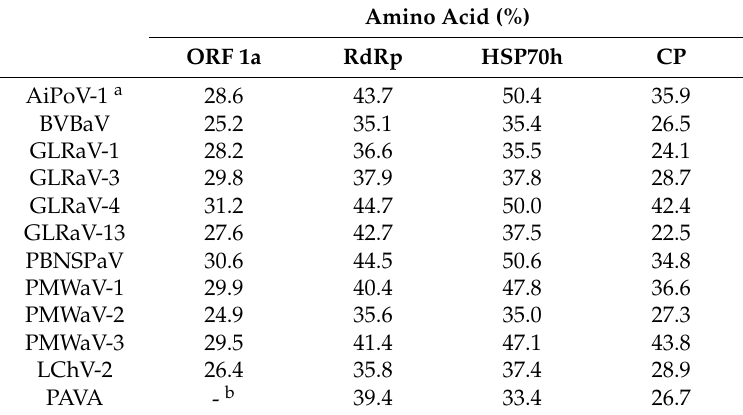
Figure 2. Multiple alignments of FLRaV open reading frames (ORFs) with other ampeloviruses. ( a ) Multiple alignments of ORF1a L-PRO of FLRaV and other ampeloviruses. Triangles indicate the conserved catalytic cysteine and histidine residues. ( b ) Multiple alignments of ORF1a HEL of FLRaV and other ampeloviruses. Red boxes indicate six conserved motifs. ( c ) Multiple alignments of RdRp of FLRaV and other ampeloviruses. Red boxes indicate eight conserved motifs. ( d ) Multiple alignments of CP of FLRaV and other ampeloviruses. Triangles indicate four N, R, G and D residues of the filamentous plant virus coat protein. Table 1. Amino acid sequence identity between proteins encoded by FLRaV and other